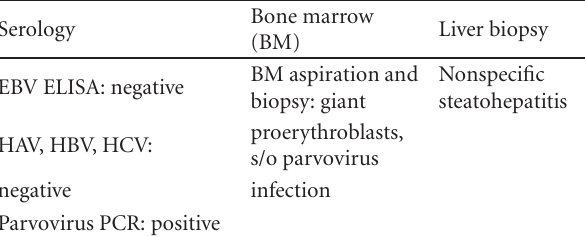
Table 2: Laboratory